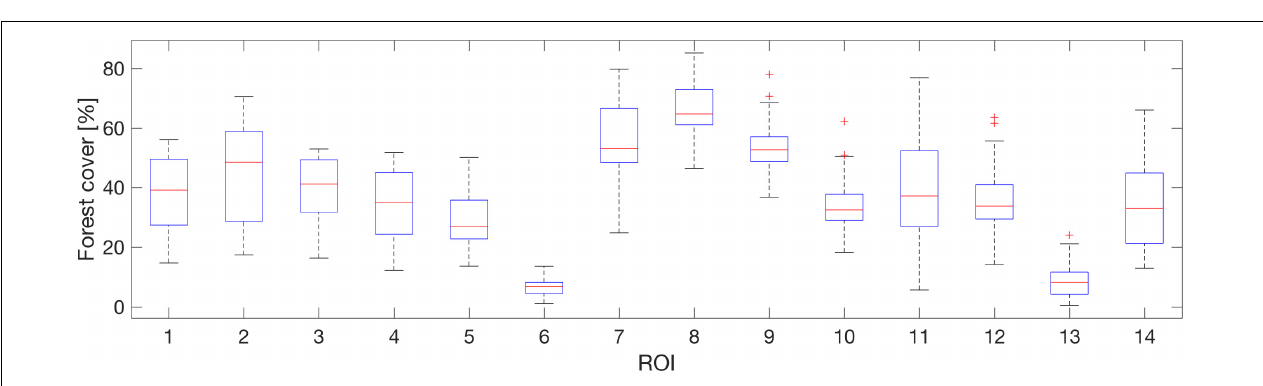
FIGURE 6 | Boxplots of forest cover in all ROIs 1987–2017. ROIs 1 & 5 are the western and eastern forest regions (cf. Figure 1 ).